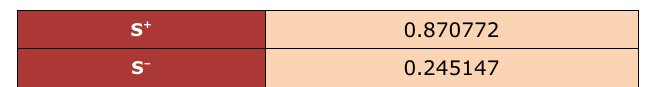
Step8. Calculating the overall performance index